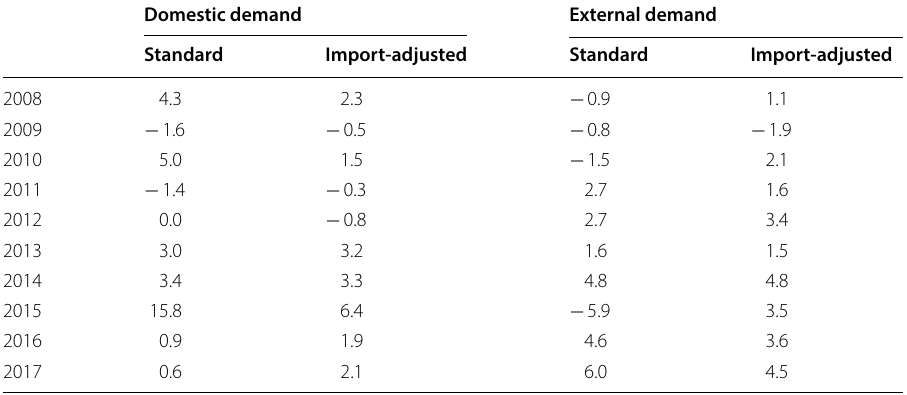
Table 3 Comparison of contributions to GDP growth—standard versus import‑adjusted (percentage points of